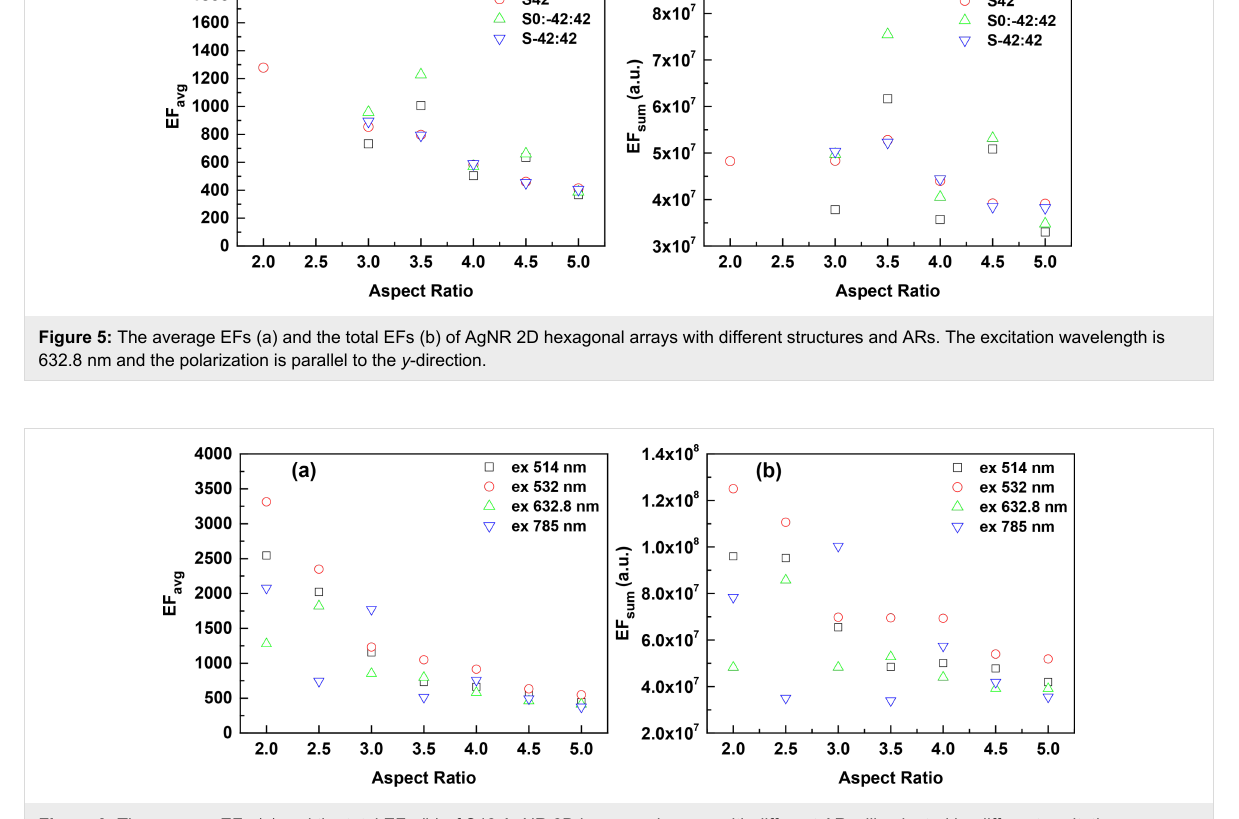
Figure 6: The average EFs (a) and the total EFs (b) of S42 AgNR 2D hexagonal arrays with different ARs, illuminated by different excitation wave- lengths (i.e., 514, 532, 632.8 and 785 nm) with the polarization parallel to the y